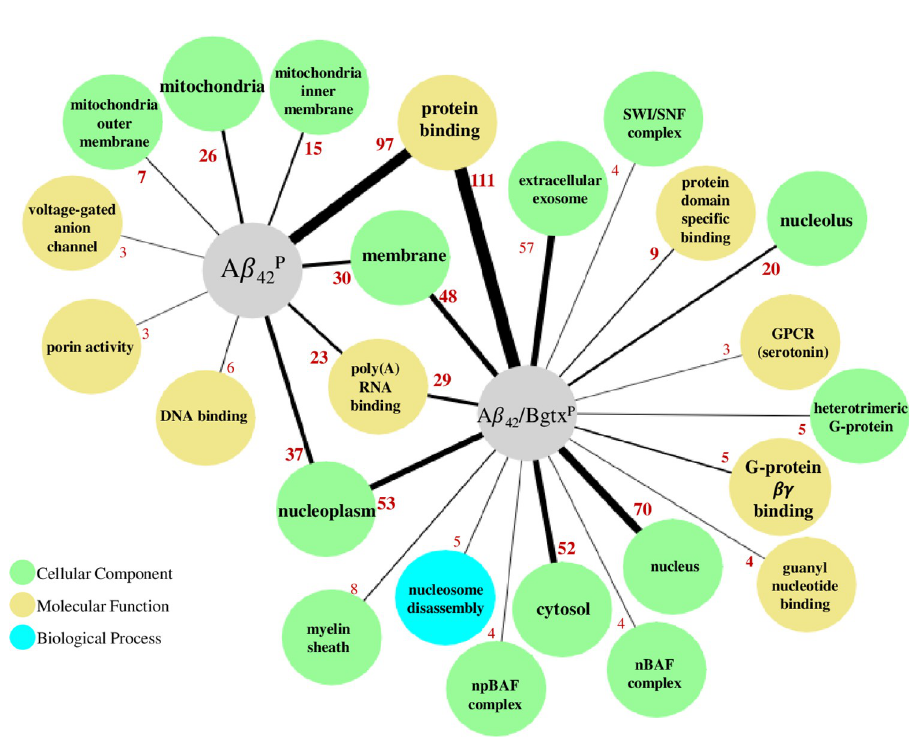
Fig 5. DAVID enrichment analysis of A β 42P and A β /Bgtx P . GO terms associated with A β 42P and A β 42 /Bgtx P . The number of proteins associated with each GO term are indicated by edge width and red lettering.